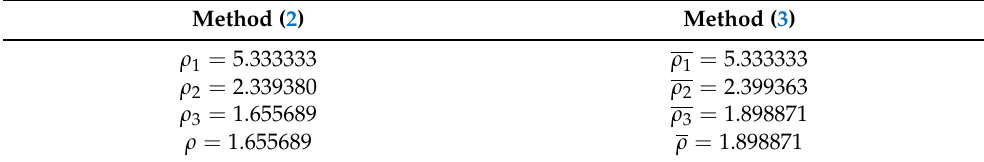
Table 3. Comparison of convergence radii for Example